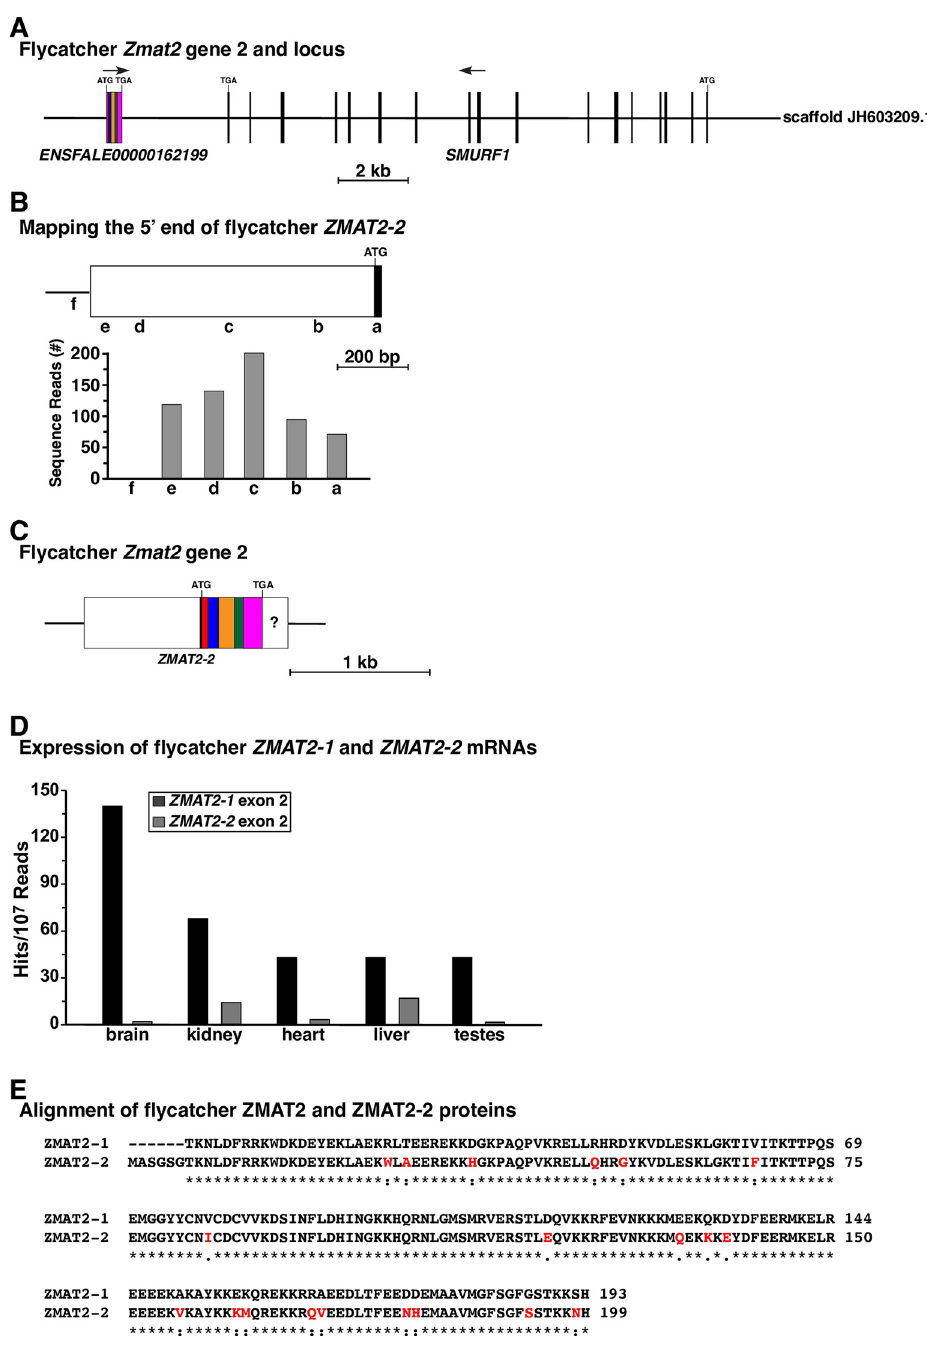
Fig 4. The flycatcher genome contains a second Zmat2 gene. A . Schematic of flycatcher Zmat2 gene 2 and its location adjacent to Smurf1 . Locations of ATG and TGA codons are indicated, and a scale bar is shown. Color-coding indicates regions that are similar in DNA sequence to individual exons of Zmat2 gene 1. B . Mapping the 5’ end of exon 1 of Zmat2 gene 2. The diagram illustrates exon 1, with the graph below showing gene expression data from NCBI SRA RNA-sequencing library, SRX6380621 (Additional S1 Table), using 60 base pair genomic segments a-f as probes. C . Diagram of flycatcher Zmat2-2 mRNA, with coding regions in different colors and non-coding segments in white. The question mark indicates that the 3’ end could not be mapped because of identity with Zmat2-1 . D . Gene expression data for both flycatcher Zmat2 mRNA species, using probes from exon 2 of each gene (Additional S2 Table) that discriminate between transcripts. E . Alignment of amino acid sequences of flycatcher ZMAT2 proteins. Similarities and differences are shown, with identities being indicated by asterisks, and differences by colons. Differences in ZMAT2-2 also are marked in